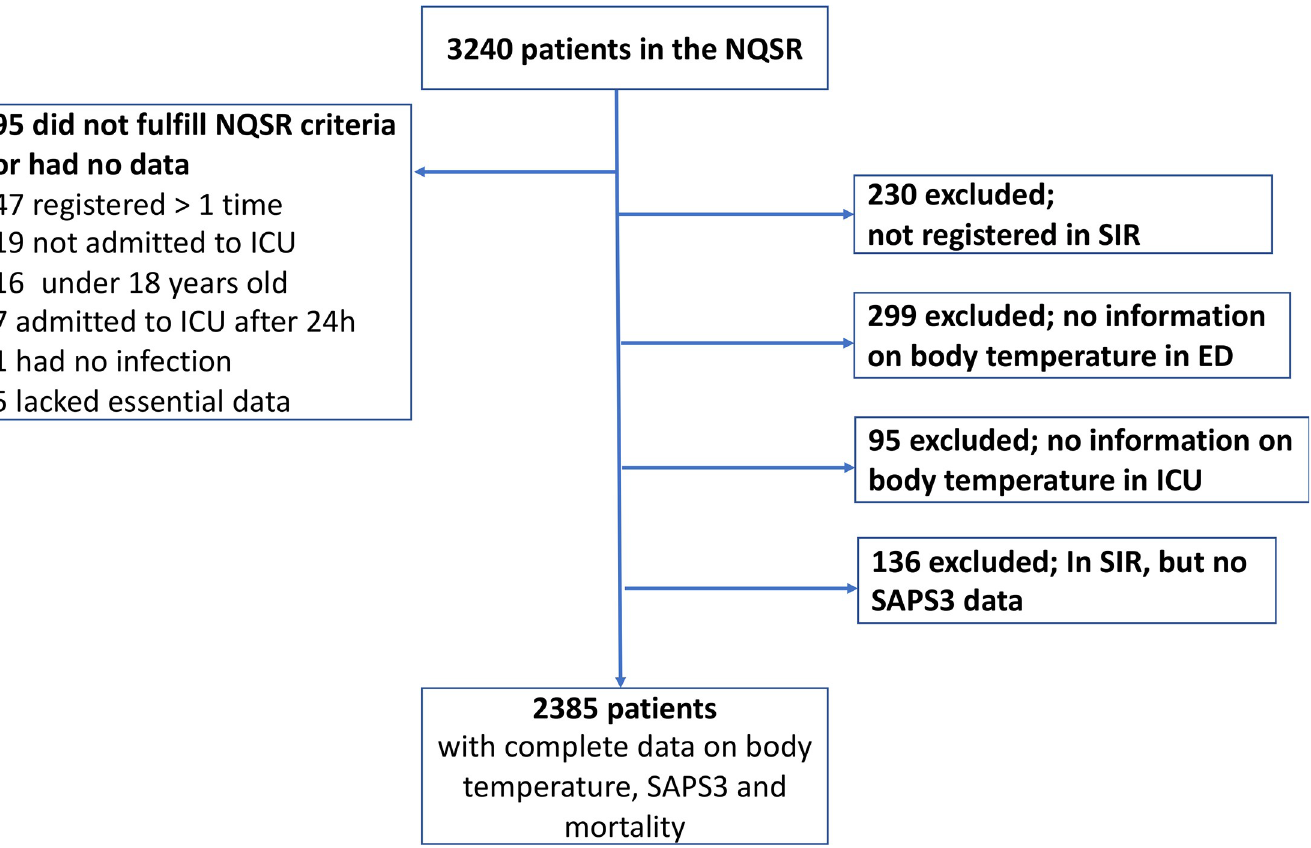
Fig 1. Ninety-five patients did not fulfill inclusion criteria or lacked essential data. 230 were were not registered in SIR. 299 lacked recorded body temperature in the ED and 95 lacked recorded maximum temperature around ICU admittance. A final 136 patients were excluded since a different severity score was used in the ICU and they lacked SAPS3